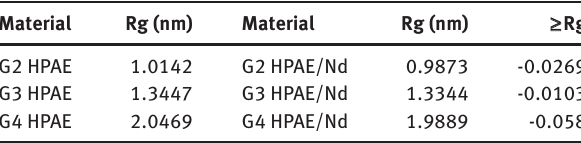
Table 6 Gyration radius of G2–G4 HPAE and the corresponding composite system.